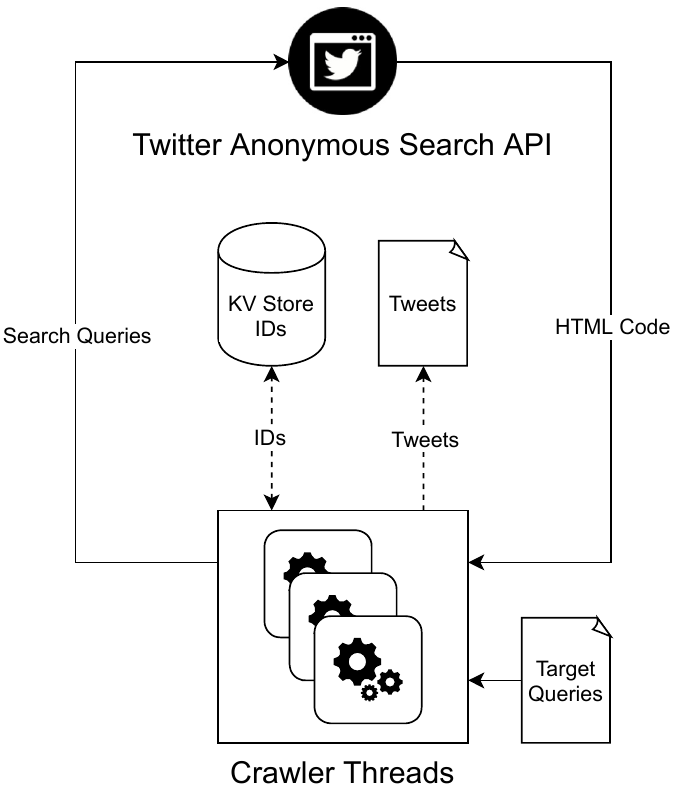
Figure 2. High-level Twitter crawler architecture.